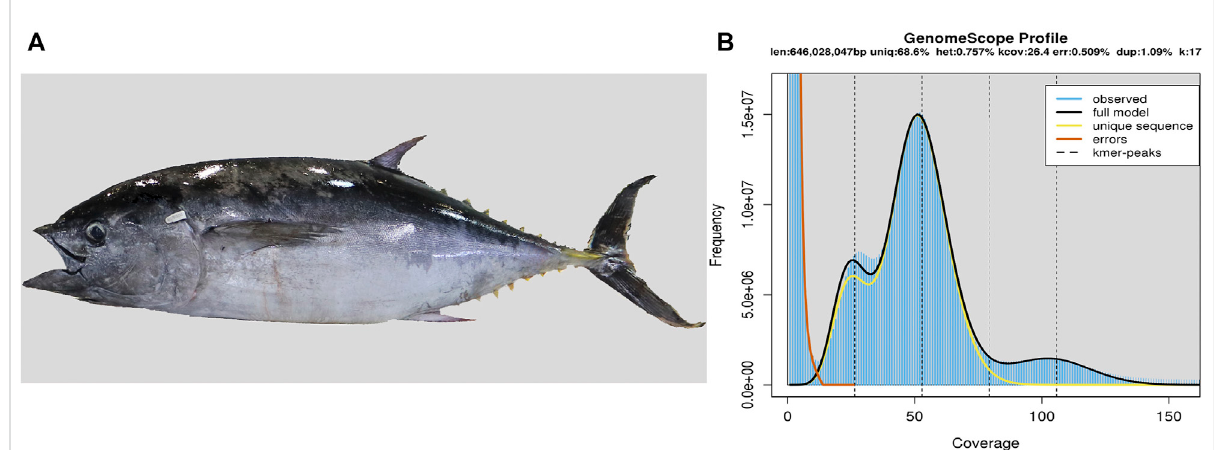
FIGURE 1 Southern blue fi ntuna and itsgenome size estimation. (A) Photoofthesequenced tuna. (B) Estimation ofthegenome sizebased on theroutine k-mer analysis (You et al., 2014). The X -axis is the depth of k-mers derived from the sequenced reads, and the Y -axis represents the frequency of k-mer depth. Genome size (G) is estimated as follows: G = k_num/peak_depth, where the total number of k-mers (k_num) is 44,309,018,345, and the expected value of k-mer depth (peak_depth) is 52. Therefore, we predicted the genome size of Southern blue fi n tuna to be about 852